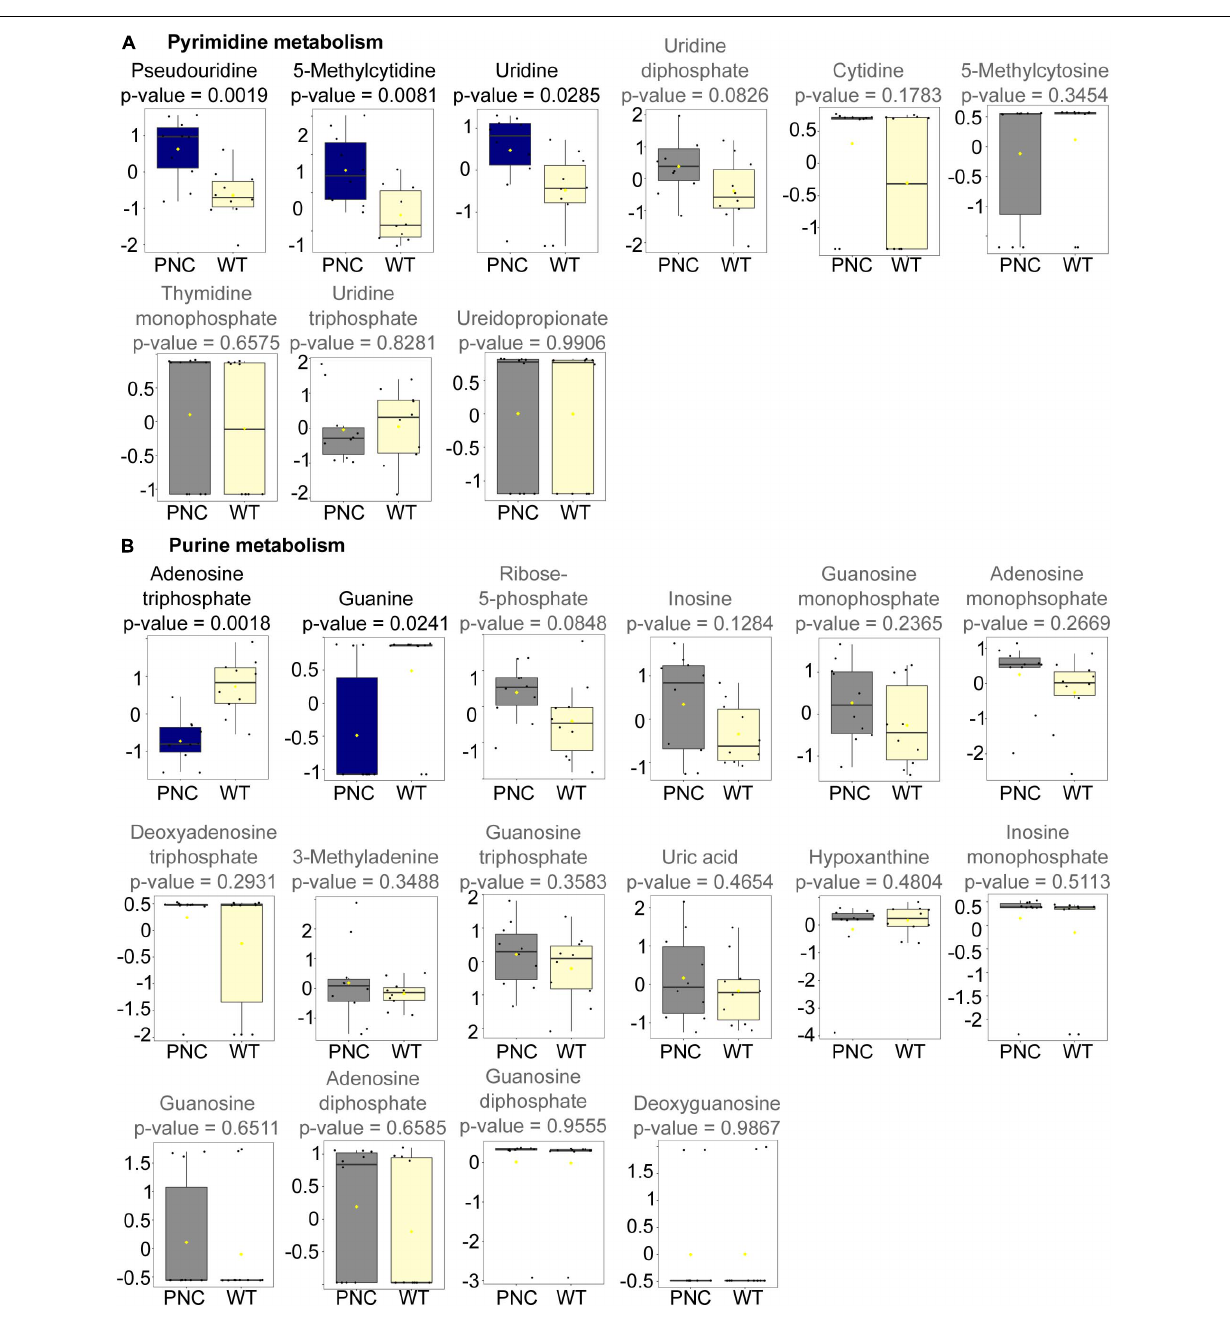
FIGURE 5 | Metabolites significantly altered upon HRAS G12V induction in PNCs. Box and whisker plots generated using MetaboAnalyst 5.0 online platform for individual metabolites in pyrimidine (A) and purine (B) metabolism identified in our dataset are presented with the statistically significant ( p < 0.05) altered metabolites presented in blue and the non-significantly altered metabolites presented in gray. The boxplots represent median ± interquartile range of log transformed and auto-scaled intensities for preneoplastic cell (PNC) and control (WT) groups ( N =